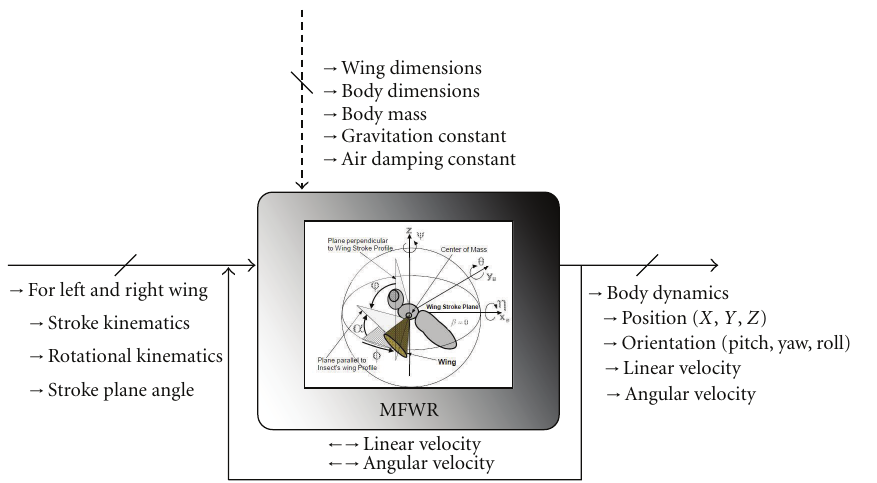
Figure 3: Schematic of the simulated Microlevel Flapping Winged Robot